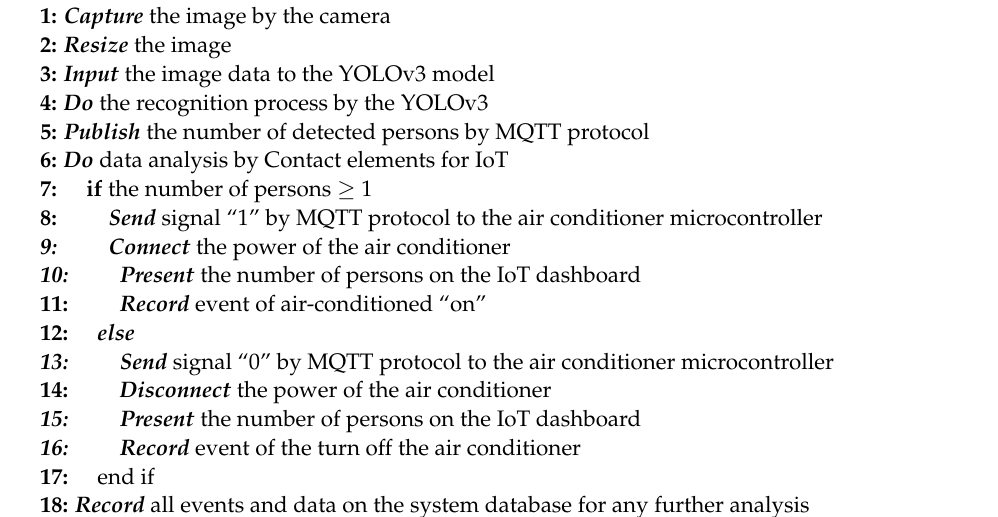
Algorithm 1 The Pseudo-Code of Air Conditioner Energy Control Based on